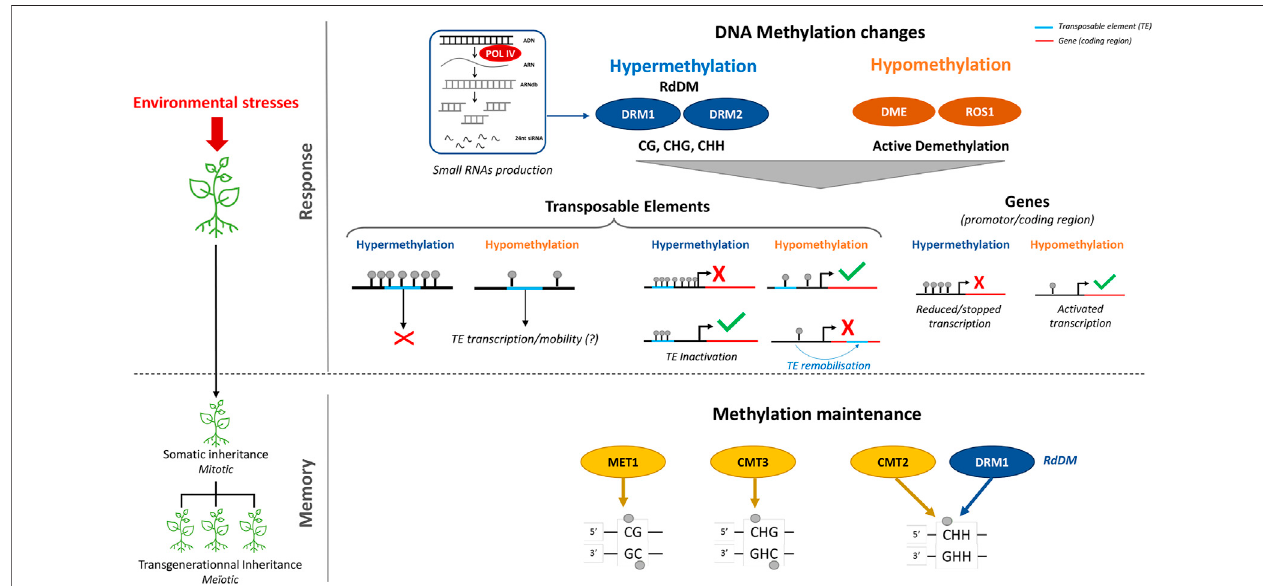
FIGURE2| RolesofDNA-methylationinenvironmentalstressresponsesandmemoriesinplants.ChangesinDNA-methylationlandscapearepartoftheresponse of plants to environmental stresses. De novo methylation, which is targeted at speci fi c loci by small-RNAs, is established by the RNA-dependent-DNA-Methylation pathway (RdDM)whereas,DNAdemethylationatspeci fi clocirequiresfunctionalDNAGlycosylaseLyasealsocalledDNAdemethylasesuchasRepressorofSilencing1 (ROS1). Modi fi cation of DNA methylation patterns at genes may result in changes in gene expression level leading to gene induction or repression. In addition, stress induced DNA methylation variations may occur at transposable elements (TEs) and determine their inactive or active state. When hypomethylated and transcriptionally active, TEs may indirectly in fl uence the expression of genes located in their vicinity, whereas their hypermethylation has the reverse effect. Additionally, the mobility of TEs may generate new regulatory patterns or mutations leading to loss of gene function when their insertion occurs in genes. Maintenance of stress induced patterns of DNA methylation through cell division (Mitosis or meiosis), results in an epigenetic memory. This memory requires the context-speci fi c DNA- methyltransferases METHYLTRANSFERASE-1 (MET1), CHROMOMETHYLASE-3 (CMT3) for CG and CHG sequence context, respectively. Methylation in the CHH sequence context is maintained by CMT2 or by the RdDM pathway in heterochromatic and euchromatic regions,